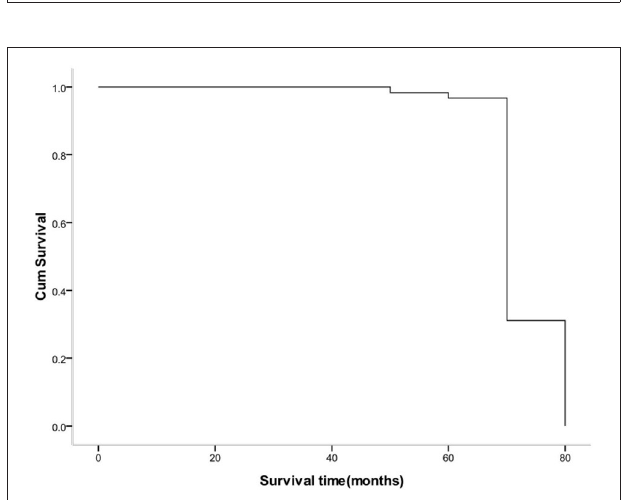
FIGURE 6 | Cumulative survival curve of hydatid patients.